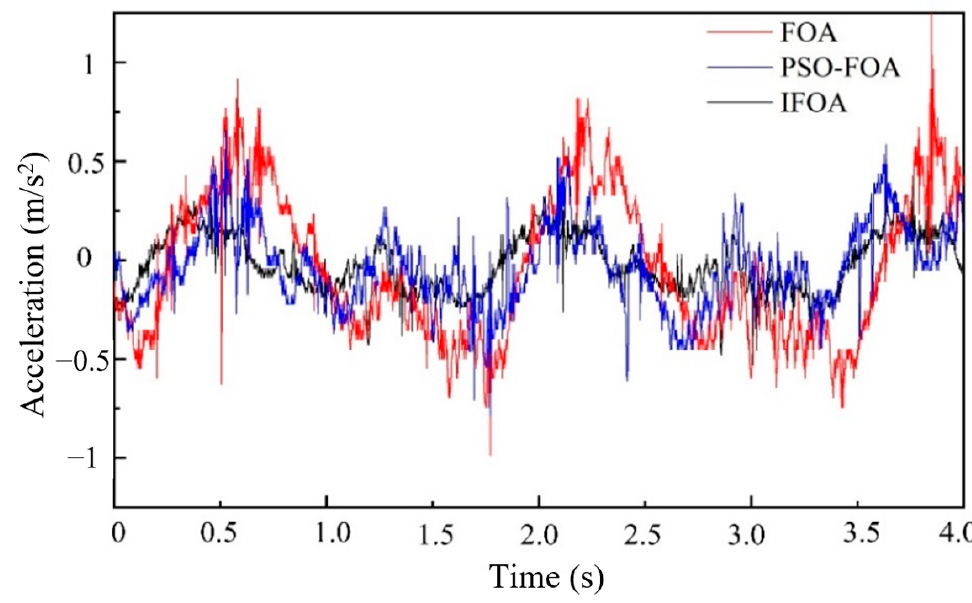
Figure 19. Acceleration of frame at low-frequency.